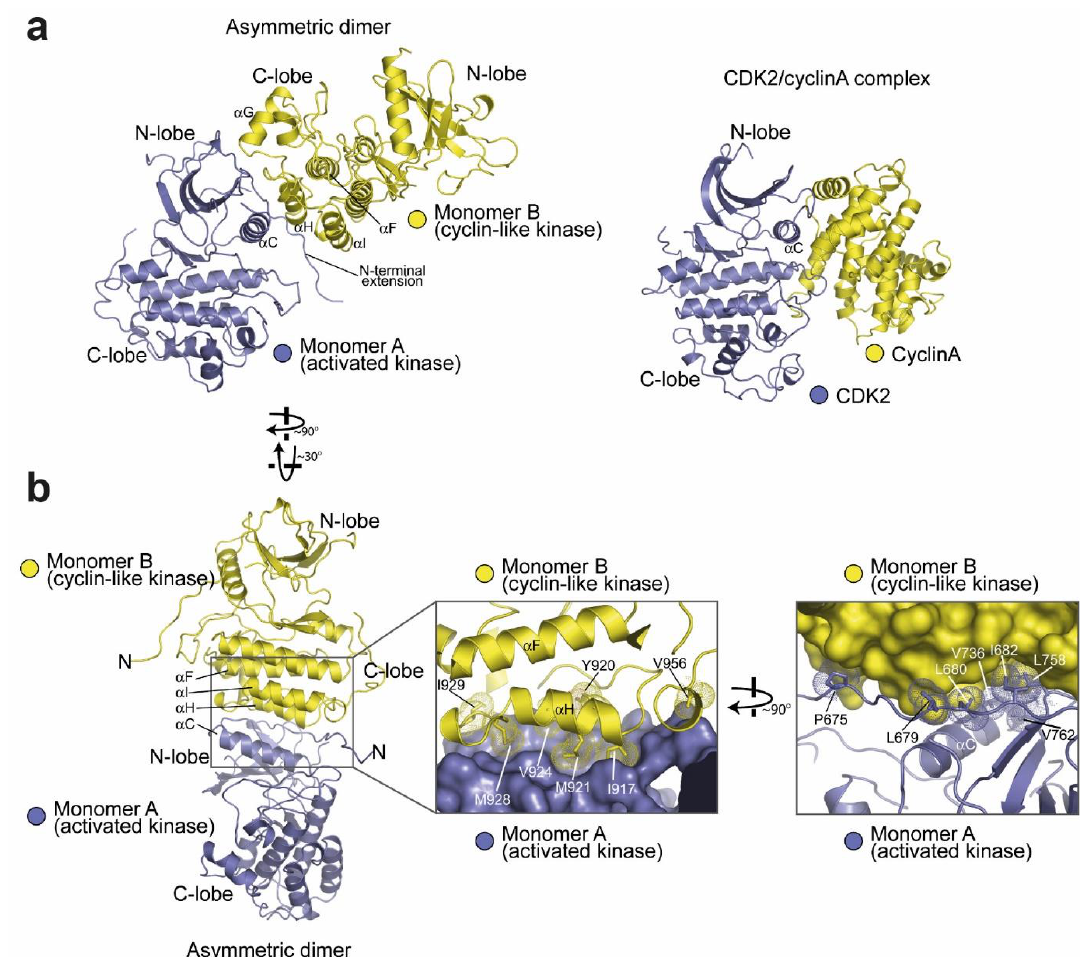
Figure 4. Structure of the asymmetric crystallographic dimer of the EGFR kinase domain (taken, with permission, from Zhang et al. [36]). ( a ) Shows an overview of the dimer (PDB:2GS6) compared with the cyclin-dependent kinase-2 (CDK2)/cyclin A complex (PDB: 1HCL). ( b ) Shows detail of the dimer interface. The first zoomed-in area (left) shows a ribbon structure for Monomer B with its hydrophobic interface residues highlighted. The second zoomed-in area (right) shows the reverse, with the hydrophobic interface residues of monomer A highlighted.